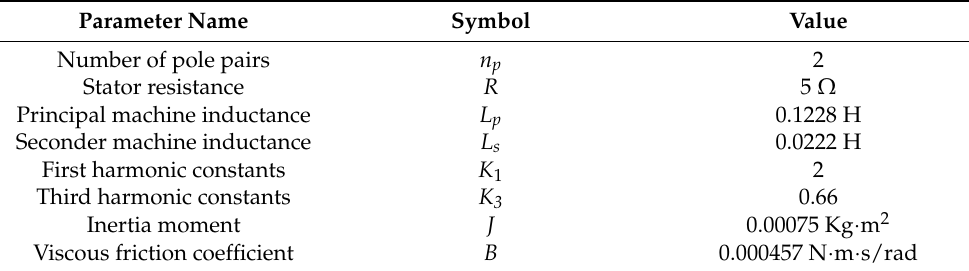
Table 1. Five-phase PMSM parameters.